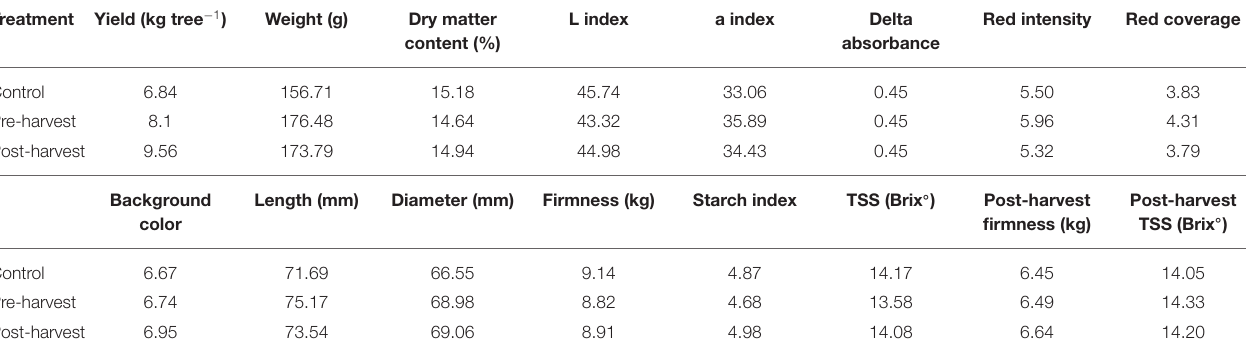
TABLE 3B | Fruit yield and quality parameters at fruit harvest and post-harvest in 2018–2019 season under the impact of different N fertigation timings. Within each parameter, different letters indicate significant differences ( p < 0.05) between treatment means ( n = 4). Treatment Yield (kg tree − 1